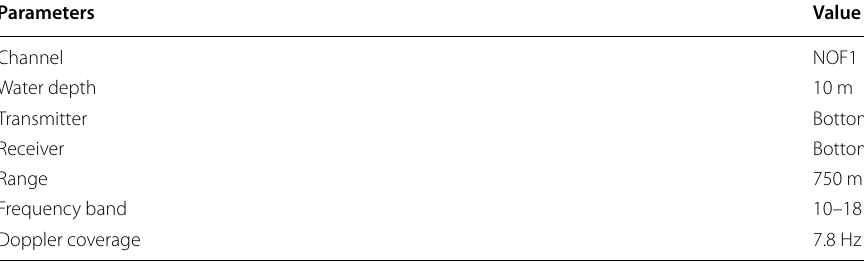
Table 2 Watermark benchmark NOF1 simulation channel parameters as given in [43]